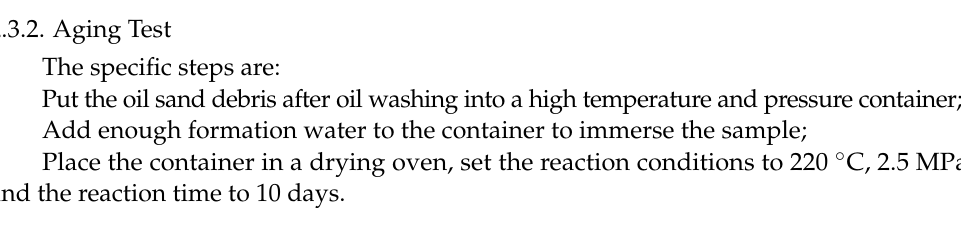
Table 4. Mineral composition of artificial clay samples (2#a).